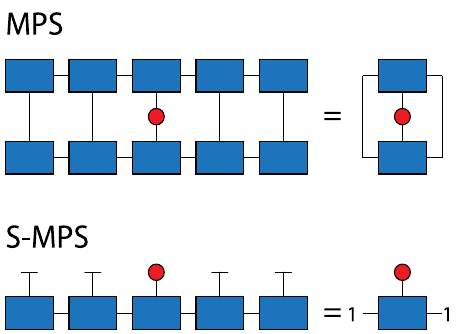
FIG. 7. Procedures for measuring local observables in a MPS in canonical form (top) and a S-MPS in canonical form